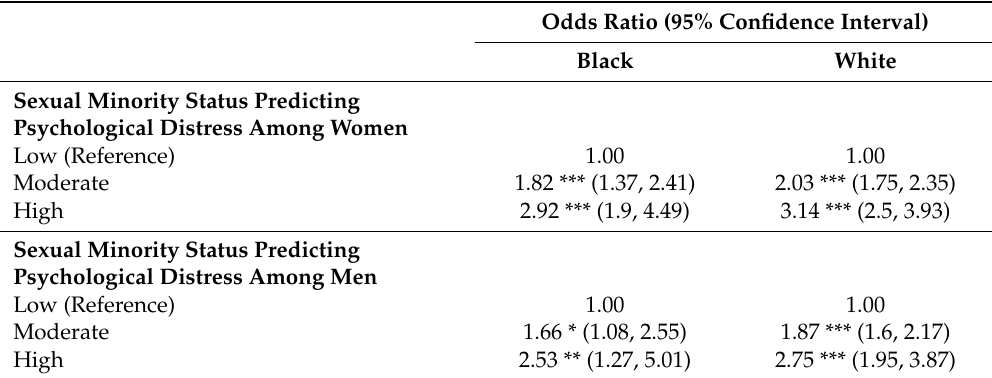
Table 2. Weighted odds ratios and confidence intervals in the associations between sexual minority status and psychological distress for each gender and racial group, 2013–2017 National Health Interview